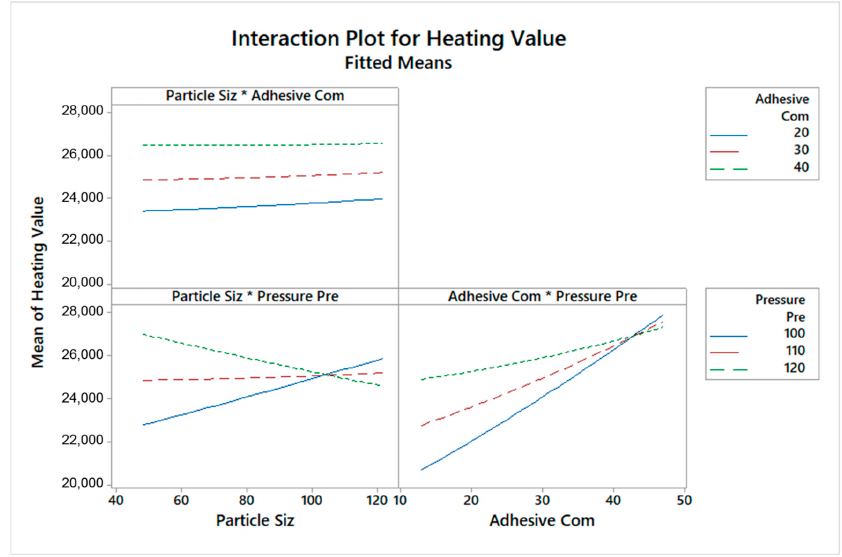
Figure 4. Two-factor interaction effect of process conditions on the heating